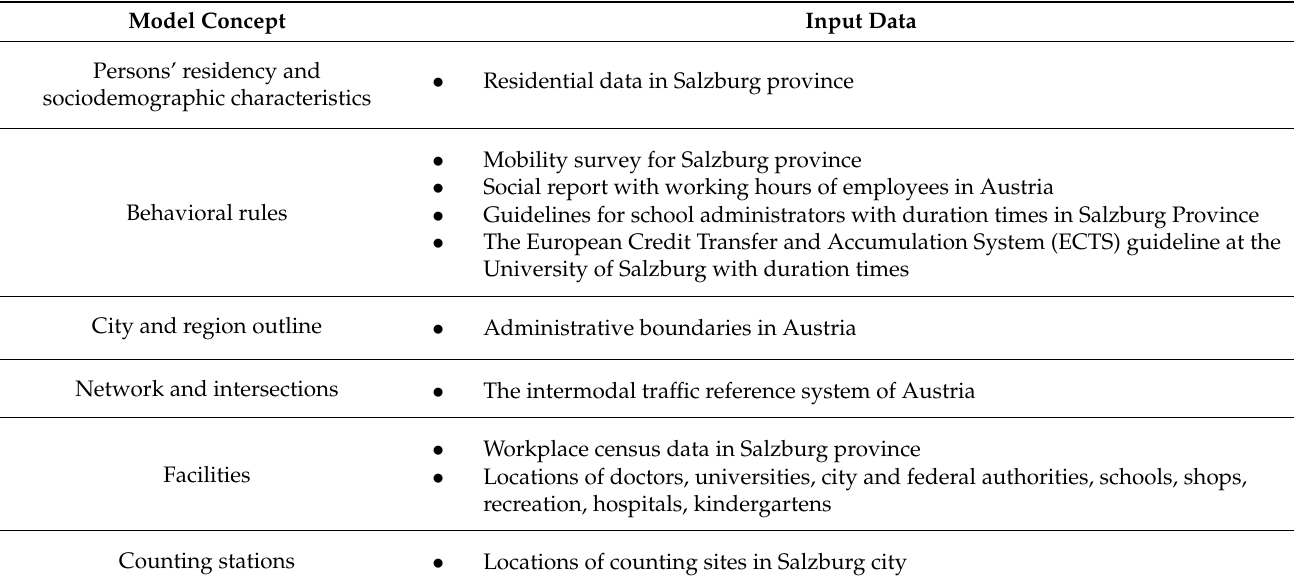
Table 3. Input data of the bicycle